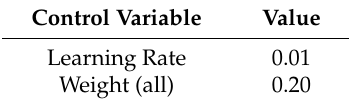
Table 1. The control variables to analyze the agricultural partial diagnosis sub-module (APDS) performance.